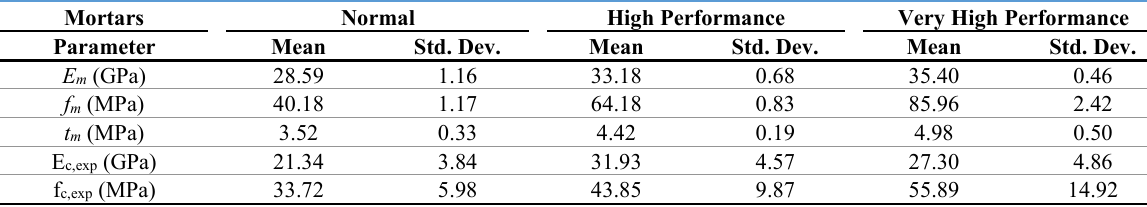
Table 3 P roperties of the mortars used in the numerical simulation Mortars Normal High Performance Very High Performance Parameter Mean Std. Dev. Mean Std.